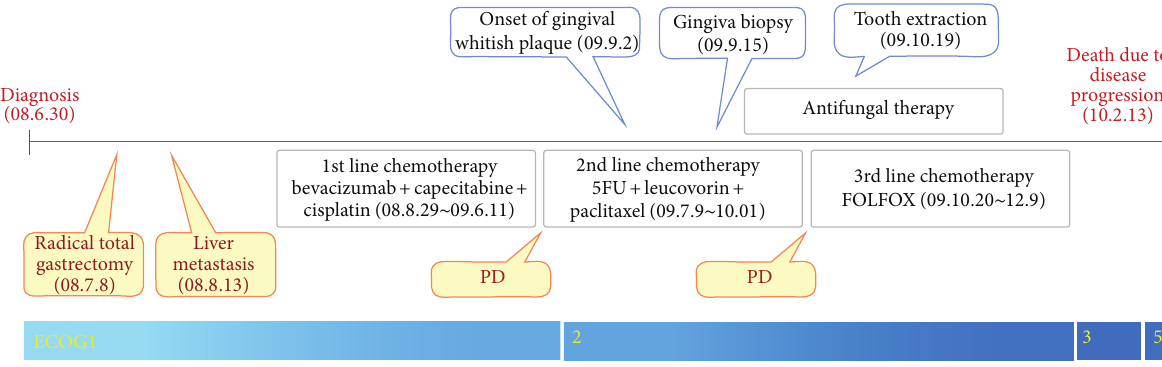
Figure 5: Summary of patient